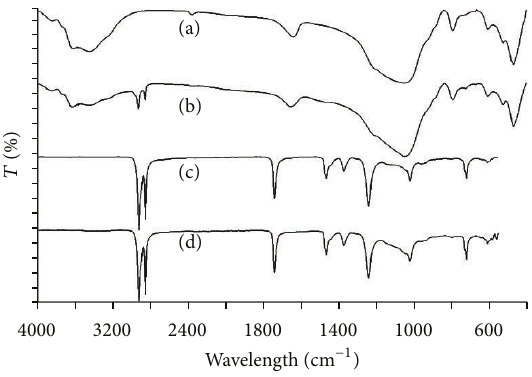
Figure 2: FTIR spectra of (a) zeolite, (b) organozeolite, (c) EVA/ zeolite composite, and (d) EVA/organozeolite